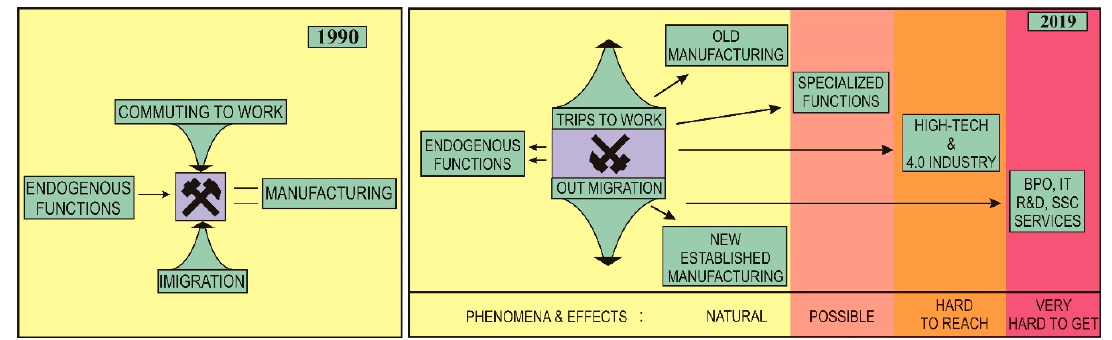
Figure 7. Socio-economic model of development of a small mining town where coal mines have been closed (illustration sourced by